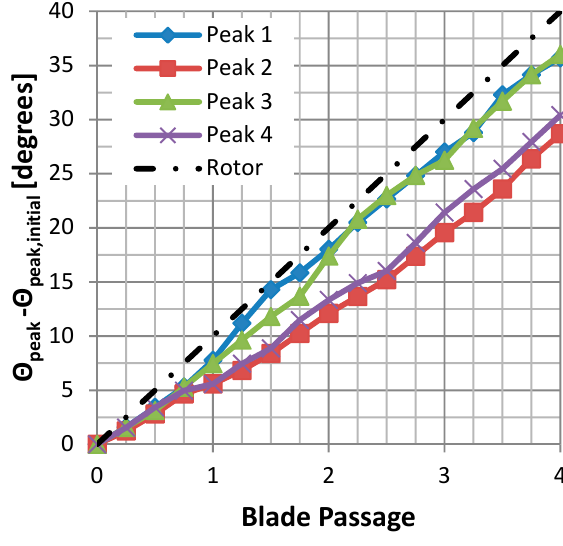
Figure 12. Static pressure peak location.